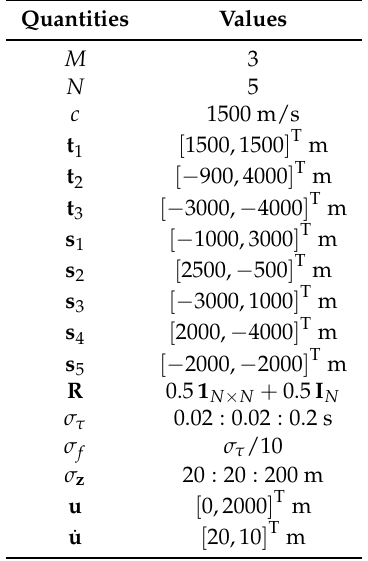
Table 4. Monte Carlo simulation